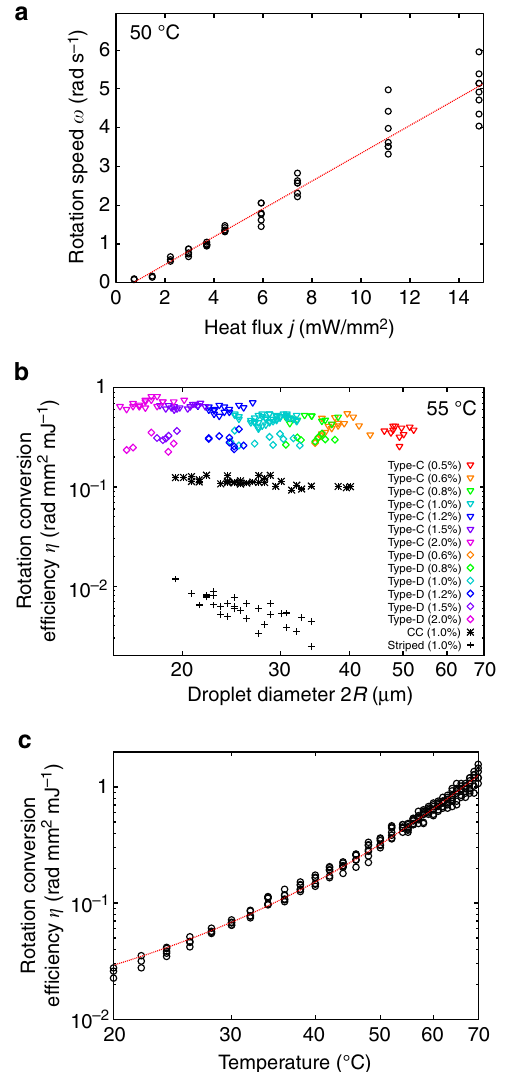
Fig. 5 Behaviour of HIR. a Linear dependence of the rotational speed ω on the applied heat fl ux j in Type-C (25 – 32 μ m diameter) with 1.0 wt% chiral dopant. b Rotation conversion ef fi ciency, η = ω / j , plotted as a function of the droplet diameter 2 R for Type-C, Type-D, striped type and CC type. See legends for the chiral content. c Temperature dependence of η in the Type- C droplets with 2 R = 25 – 32 μ m. The chiral content was 1.0 wt%. Note that the Iso-Ch transition temperature was 72 °C. As shown by the red dotted curve, the experimental data will follow the Arrhenius equation, ω = j ¼ a e (cid:2) b T þ 273 24 , where a = 4.78×10 9 rad mm 2 mJ − 1 and b = 7570K